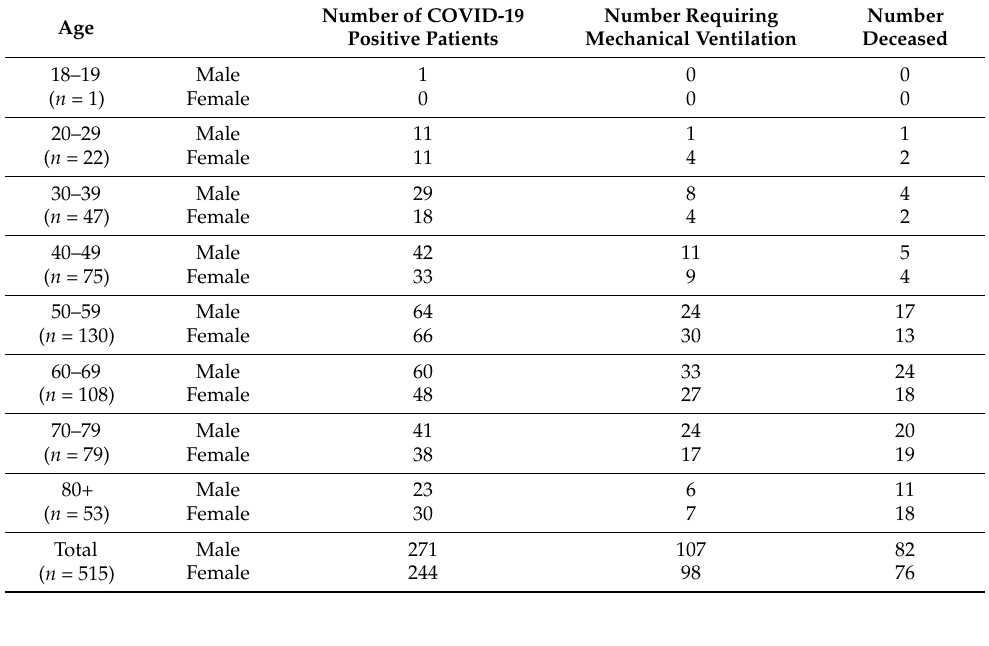
Table 2. COVID-19 positive patient outcome table.